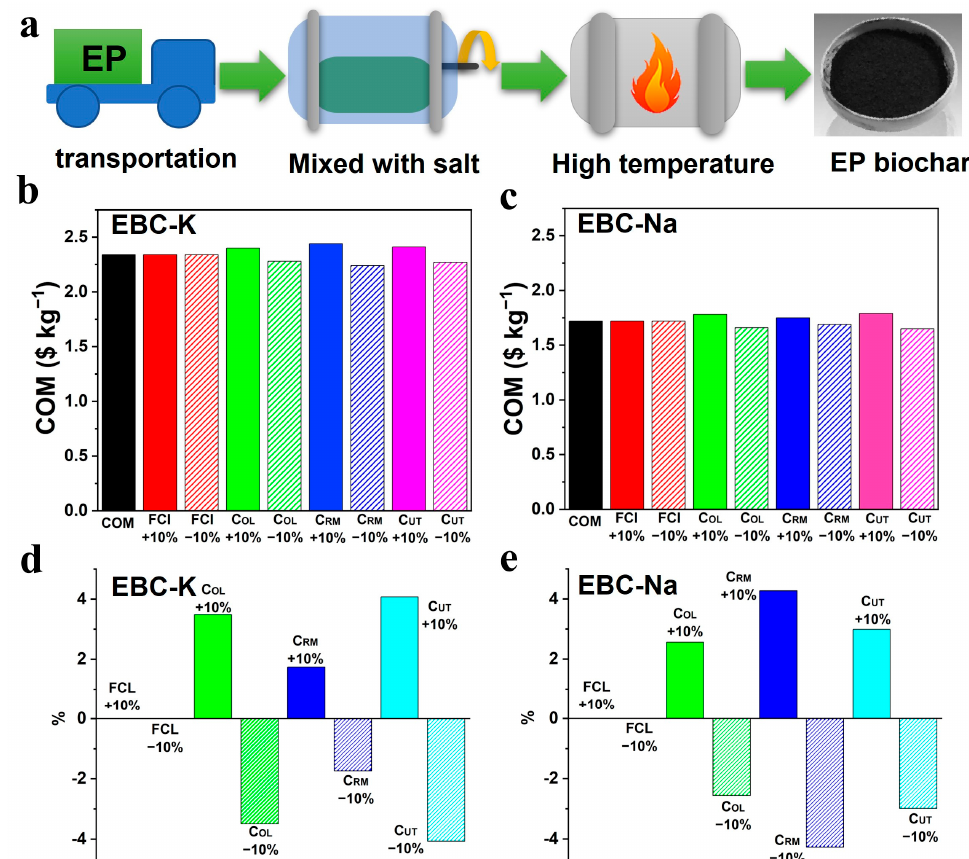
Figure 6. ( a ) The manufacturing processes of the bio-carbons derived from EP using the molten salt method; the COM of ( b ) EBC-K and ( c ) EBC-Na; the sensitivity analysis of the COM variation of ( d ) EBC-K and ( e ) EBC-Na upon the cost fluctuation with 10% increase or decrease.